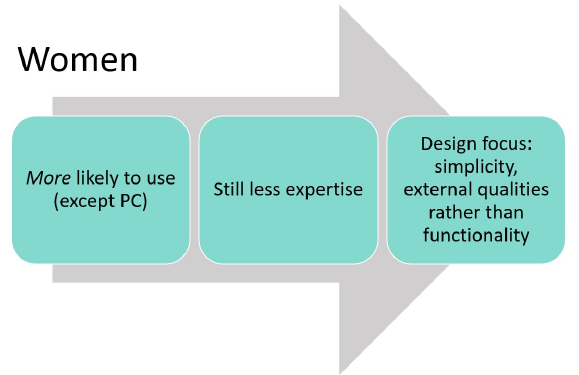
Figure 6. Overview of the opinions of computing students with regard to